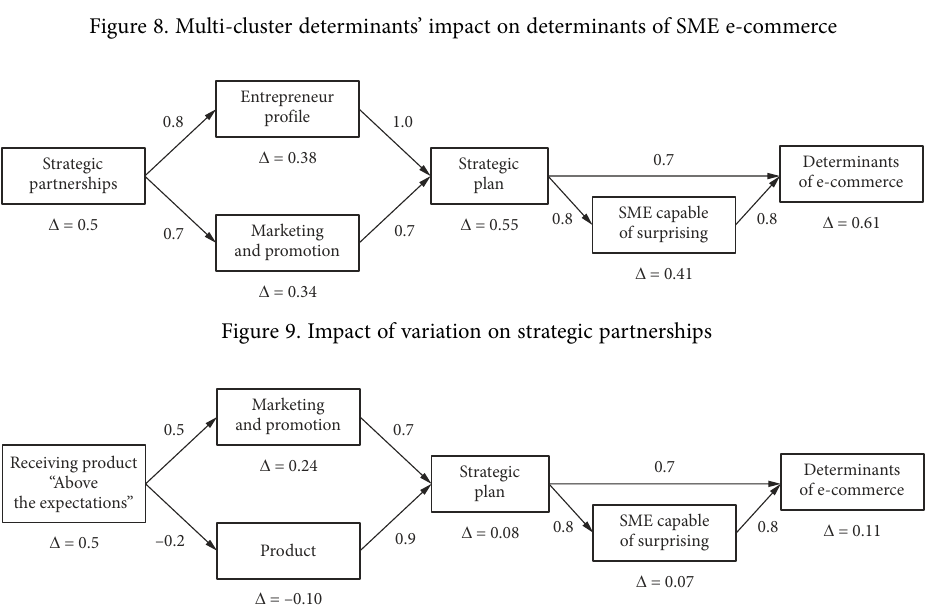
Figure 10. Impact of variation in products that exceed